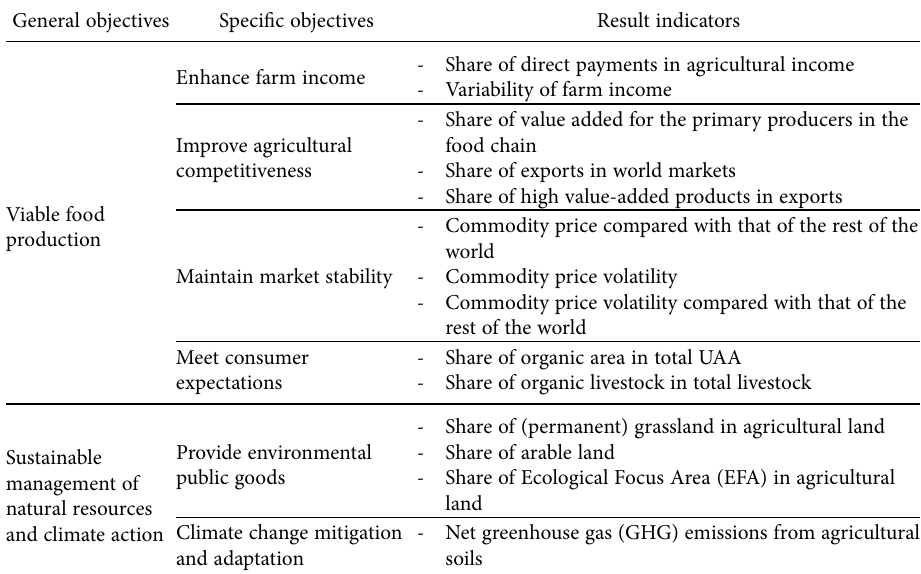
Table 1. First pillar objectives and result indicators.